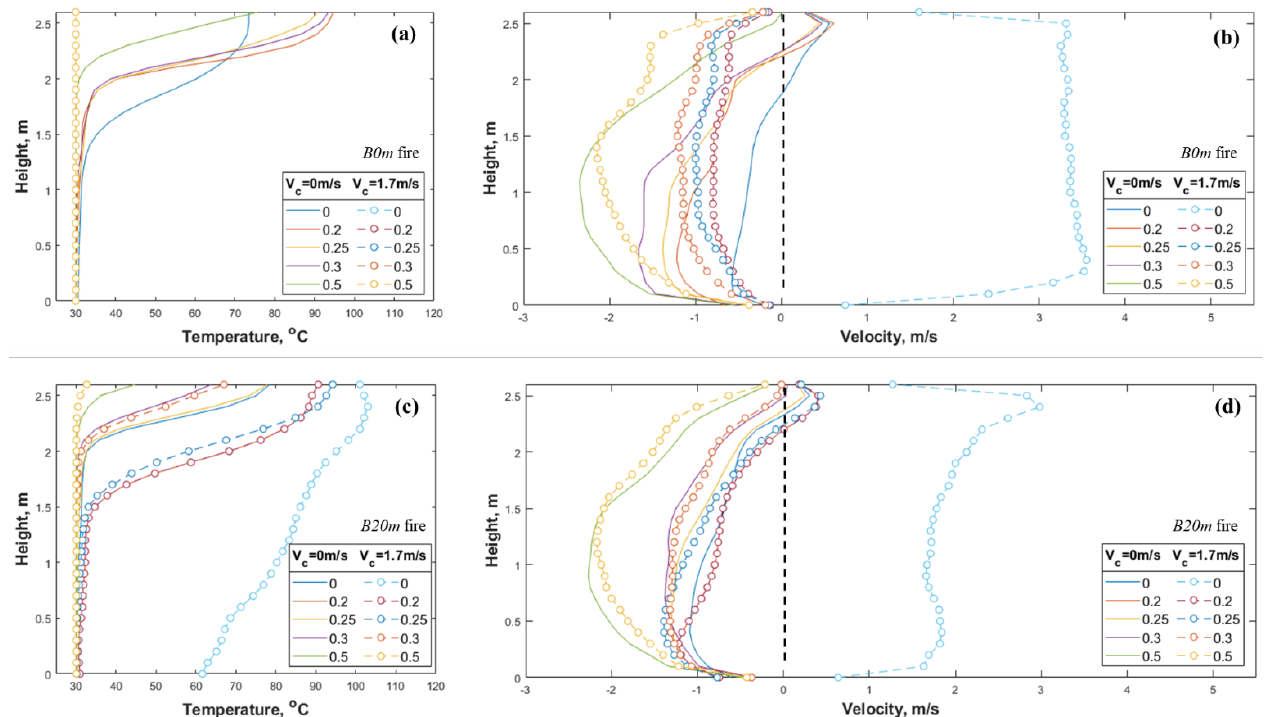
Figure 10. Top view of the smoke distribution at the cross-passage main tunnel intersection for the undercarriage fire cases.